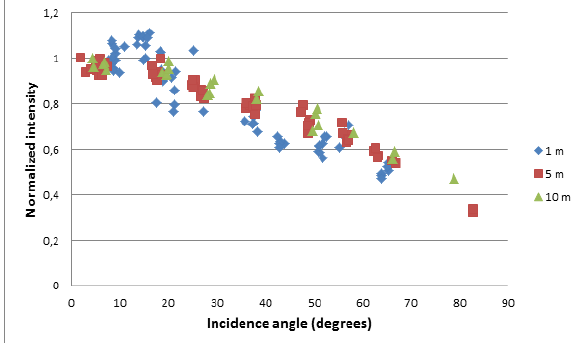
Figure 11. Comparison of the incidence angle effect of the 12 % reflectance Spectralon panel when distance effect has been corrected from the intensity data. Distances of 1, 5 and 10 meters are compared. The intensity is normalized to 1 at 0 ⁰